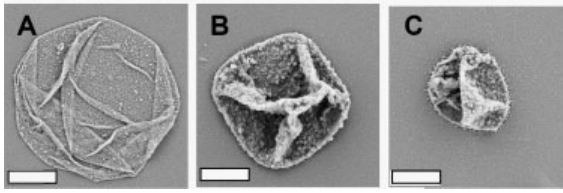
Figure 9. Scanning electron microscopy images of dried PAZO/PDDA microcapsules before irradiation ( A ), after 60 min ( B ) and after 8 h of UV light irradiation ( C ). The scale bars represent 2 μ m. Reprinted with permission from Ref. [85]. Copyright 2007 WILEY-VCH.